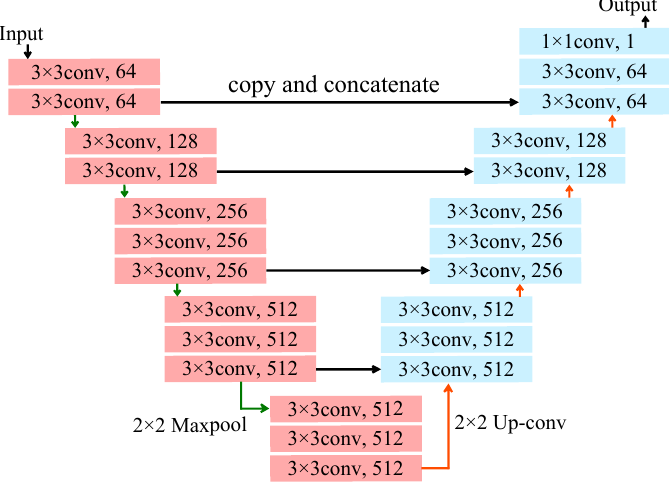
Figure 1. Network architecture of U-Net with VGG16